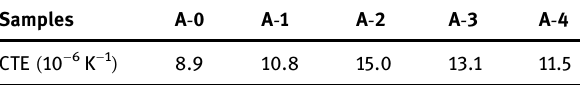
Table 4: Average CTE of composites